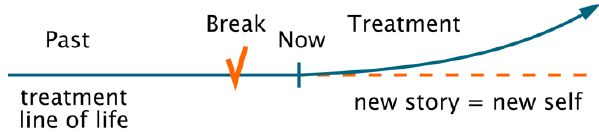
Figure 3. Treatment as creation of a new story of the self.